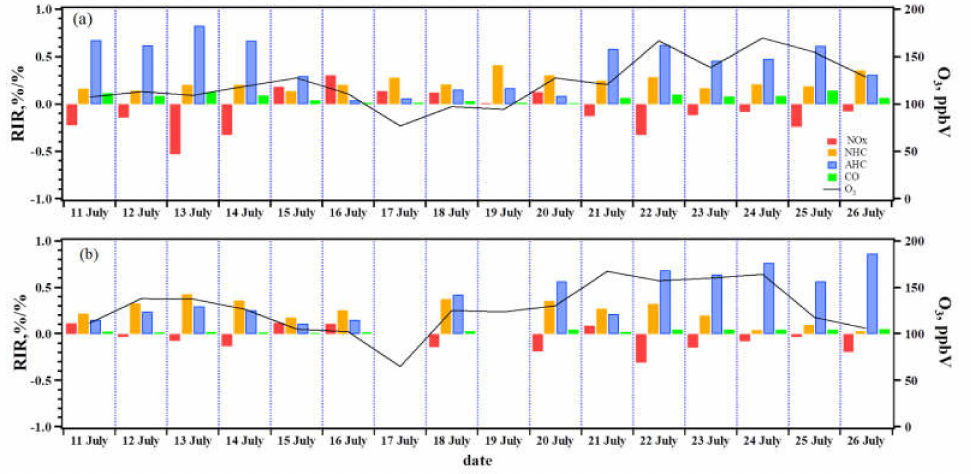
Figure 6. Variations of RIR values for NO X (red bar), NHC (orange bar), AHC (blue bar), and CO (green bar) and DMA-1h O 3 levels (black line) at ( a ) the DSH site and ( b ) the PD site from 11–26 July